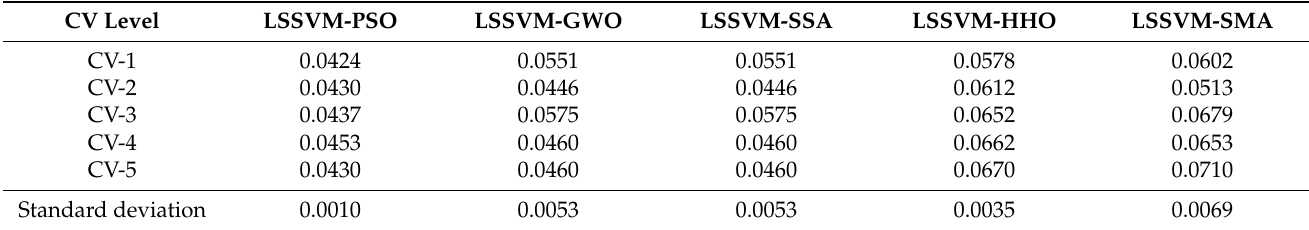
Figure 6. Convergence curve of the developed hybrid LSSVMs. Table 3. Performance of CV based on RMSE criterion for the testing dataset.